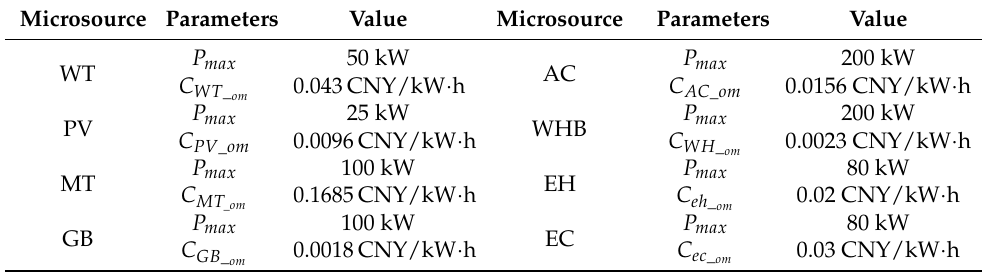
Table 6. The parameters of each micro-source in the CCHP